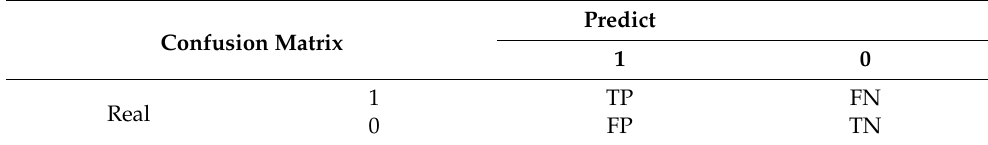
Table 2. Fuzzy rule tables based on fuzzy control.